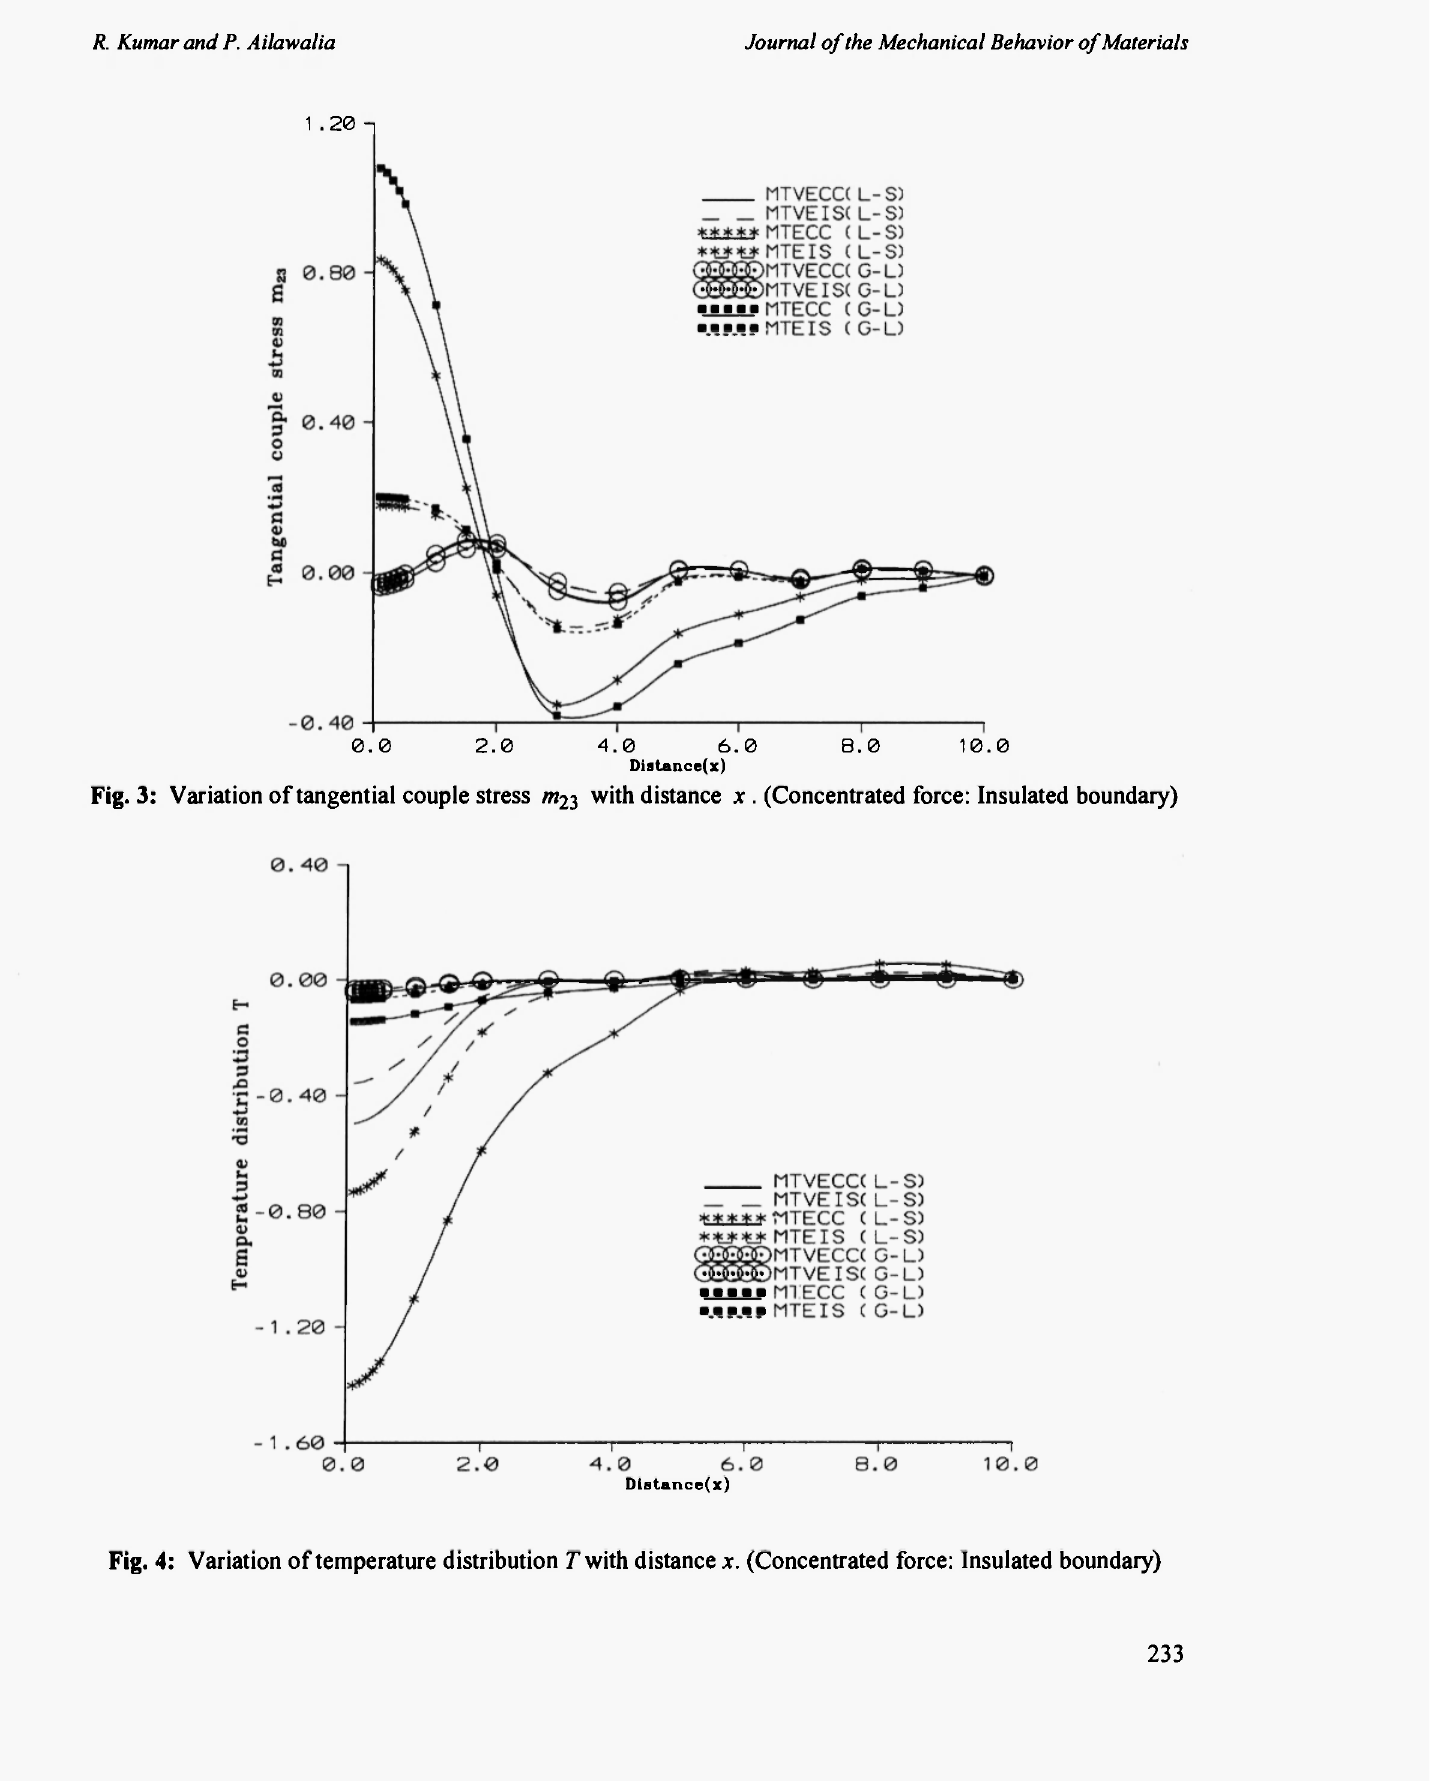
Fig. 3: Variation of tangential couple stress /m 2 3 with distance χ . (Concentrated force: Insulated boundary)